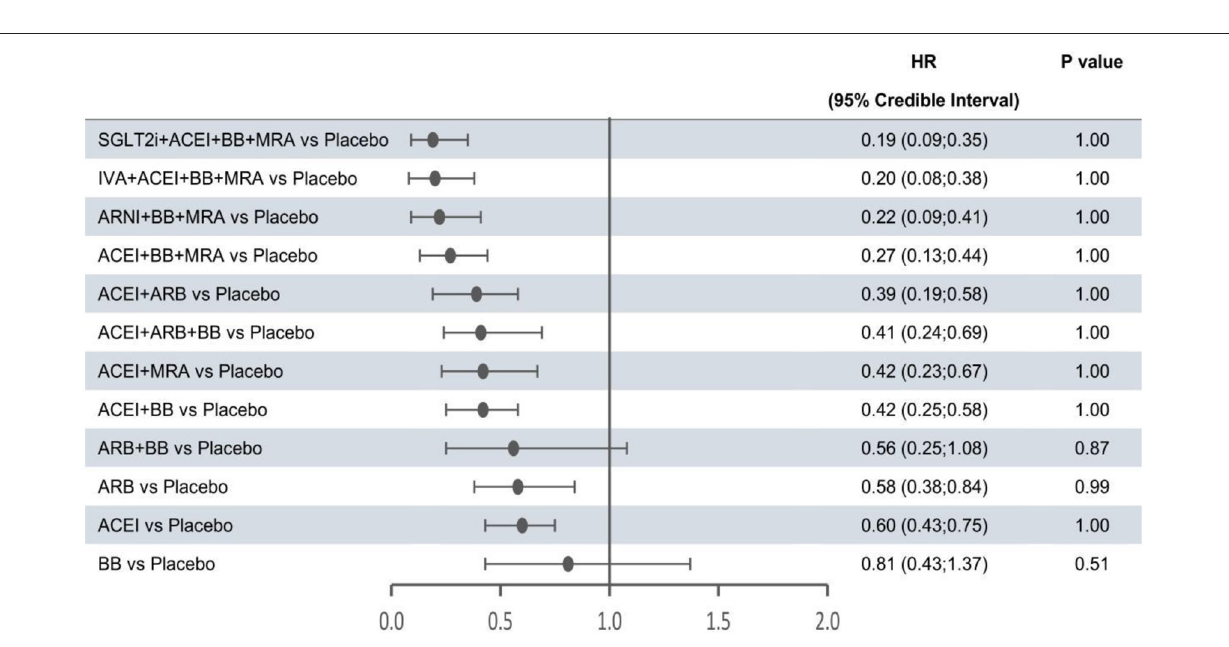
for cardiovascular mortality was lower than that for all-cause mortality. The differences in efficacy of interventions in reducing